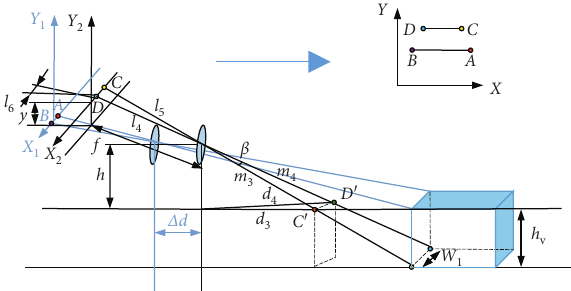
Figure 10: Schematic diagram of static pseudo-obstacle after the ego-vehicle moved.